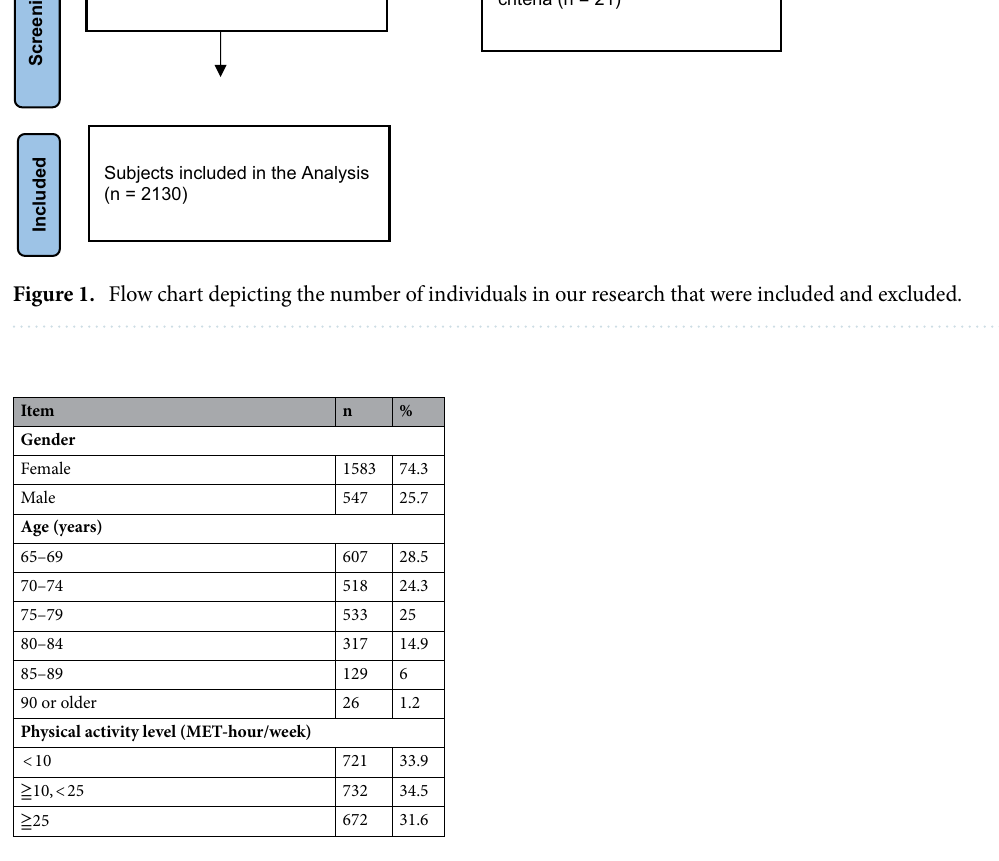
Table 1. Participant demographics ( N =